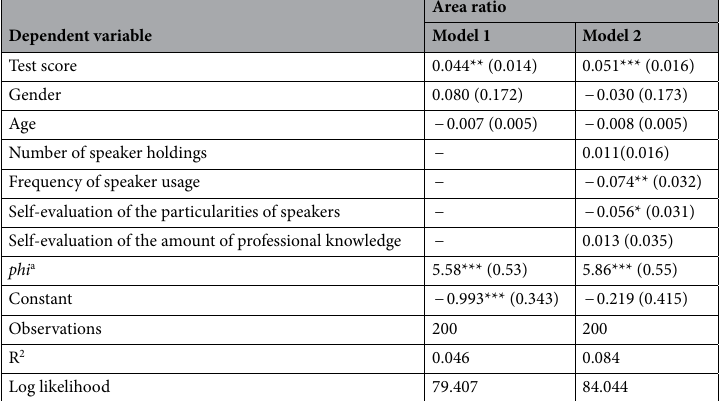
Table 2. Regression results for the area ratio of the target product in the survey data. One asterisk refers to a p -value smaller than 0.1, two asterisks to a p -value smaller than 0.05, and three asterisks to a p -value smaller than 0.01; parentheses indicate the standard error of every variable. a phi was estimated as a parameter that decided the shape of the beta-distribution for the